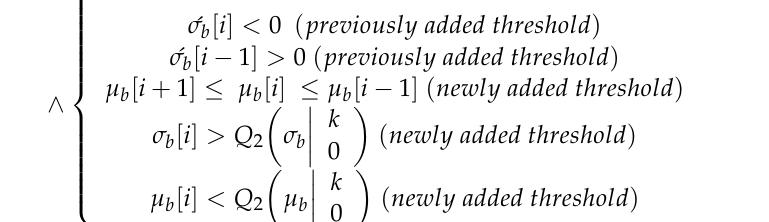
Figure 7. By deploying the new sets of thresholds in order to filter the redundant frames,